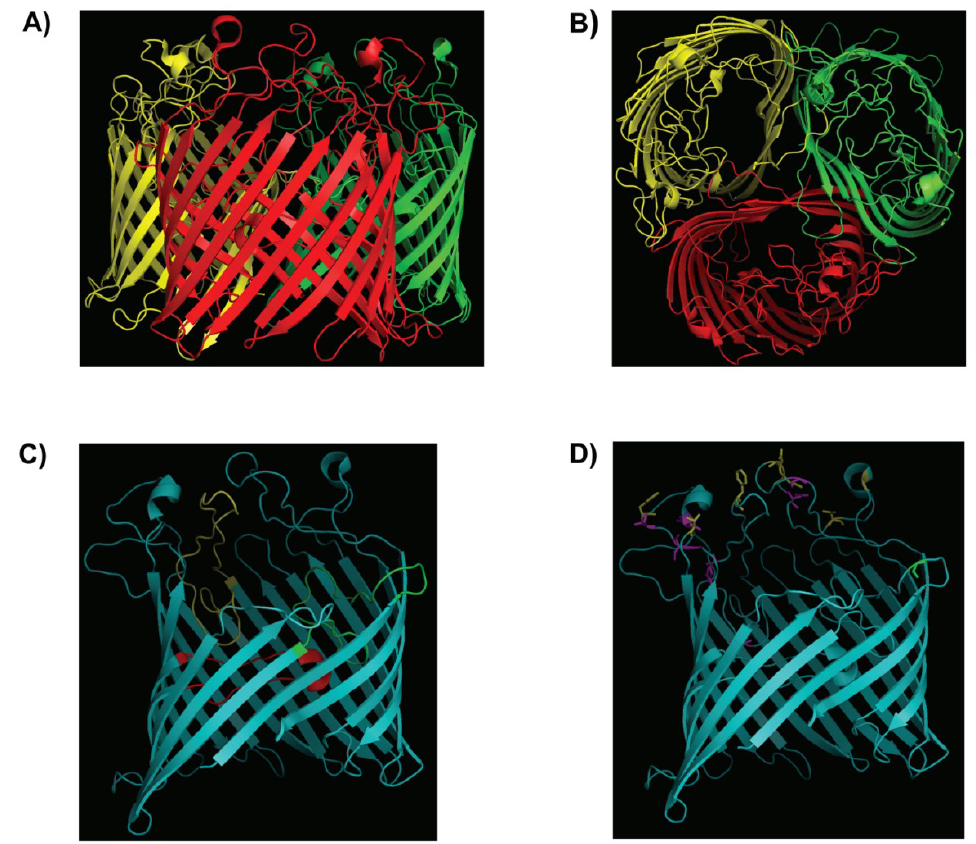
Figure 2. Crystal structure of 18 antiparallel β - strands barrel trimer LamB. ( A ) Side view and ( B ) Top view. Three monomers are shown by different colors (red, yellow and green). ( C ) Inte raction of loops in barrel. Three loops L1 (green), L3 (red) and L6 (yellow) interact with L2 from an adjacent subunit and packed against the inner wall of the barrel. ( D ) The mutation(s) of LamB confer resistance to phage infection. The surface exposed mu tant shown in yellow and the others in red. Mutation G18V is known to affect the stability of trimer and shown in green. The Adopted and modified after